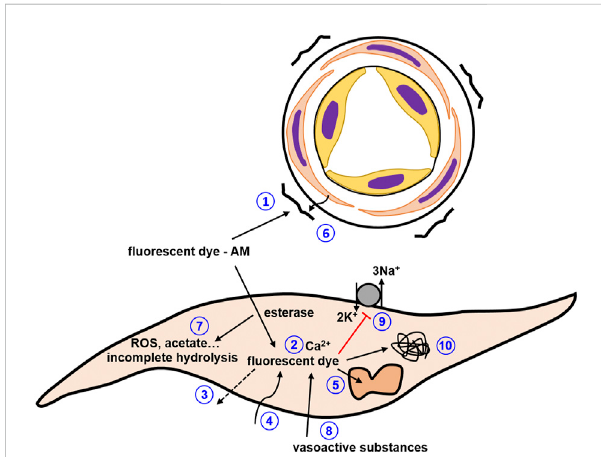
FIGURE 10 Pitfalls to beconsidered instudies with synthetic calcium dyes. 1) dye precipitates stick to the adventitia adding a strong calcium- insensitive signal; 2) buffering of intracellular calcium by calcium dye affecting the calcium concentration as well as the kinetics of calcium concentration changes; 3) dye loss; 4 ) photobleaching; 5) compartmentalization ofdyes; 6) screeningor scatter of fl uorescence by connective tissue; 7) phototoxicity and incomplete hydrolysis; 8) vasoactive substances alter fl uorescence of the dye or contribute to the fl uorescence signal; 9) inhibition ofNa/K ATPaseespeciallyat high dye concentrations; 10) interaction with intracellular